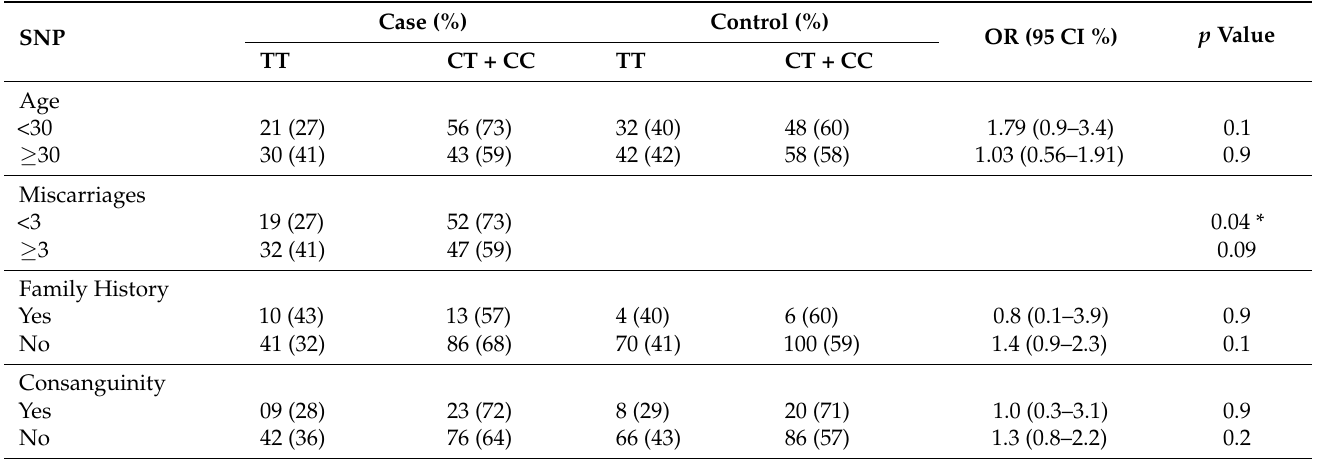
Table 3. Genotypic distribution of SNP rs12976445 C/T in RPL cases and healthy controls with different clinico-pathological characteristics.